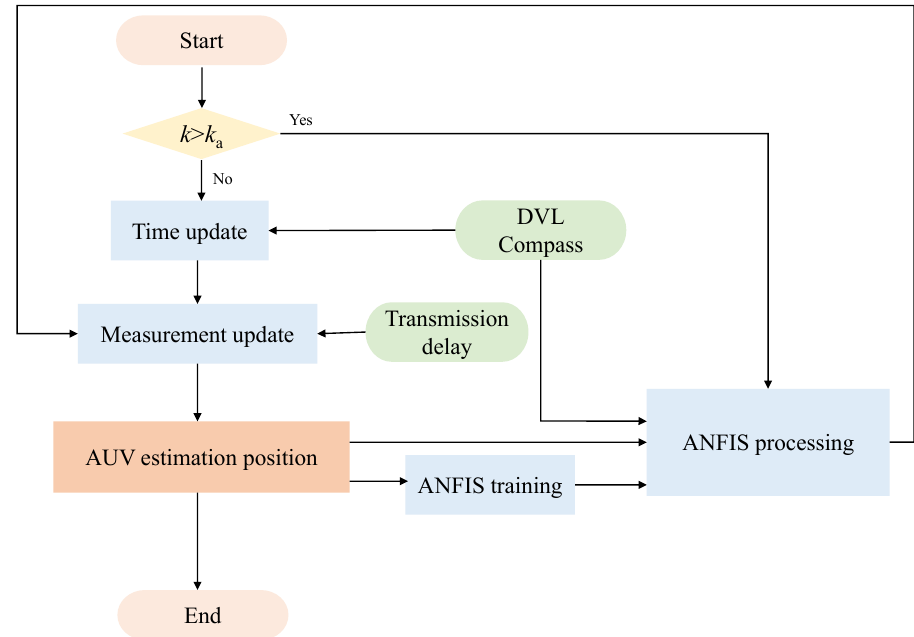
Figure 4. Flowchart of the proposed ANFIS-EKF